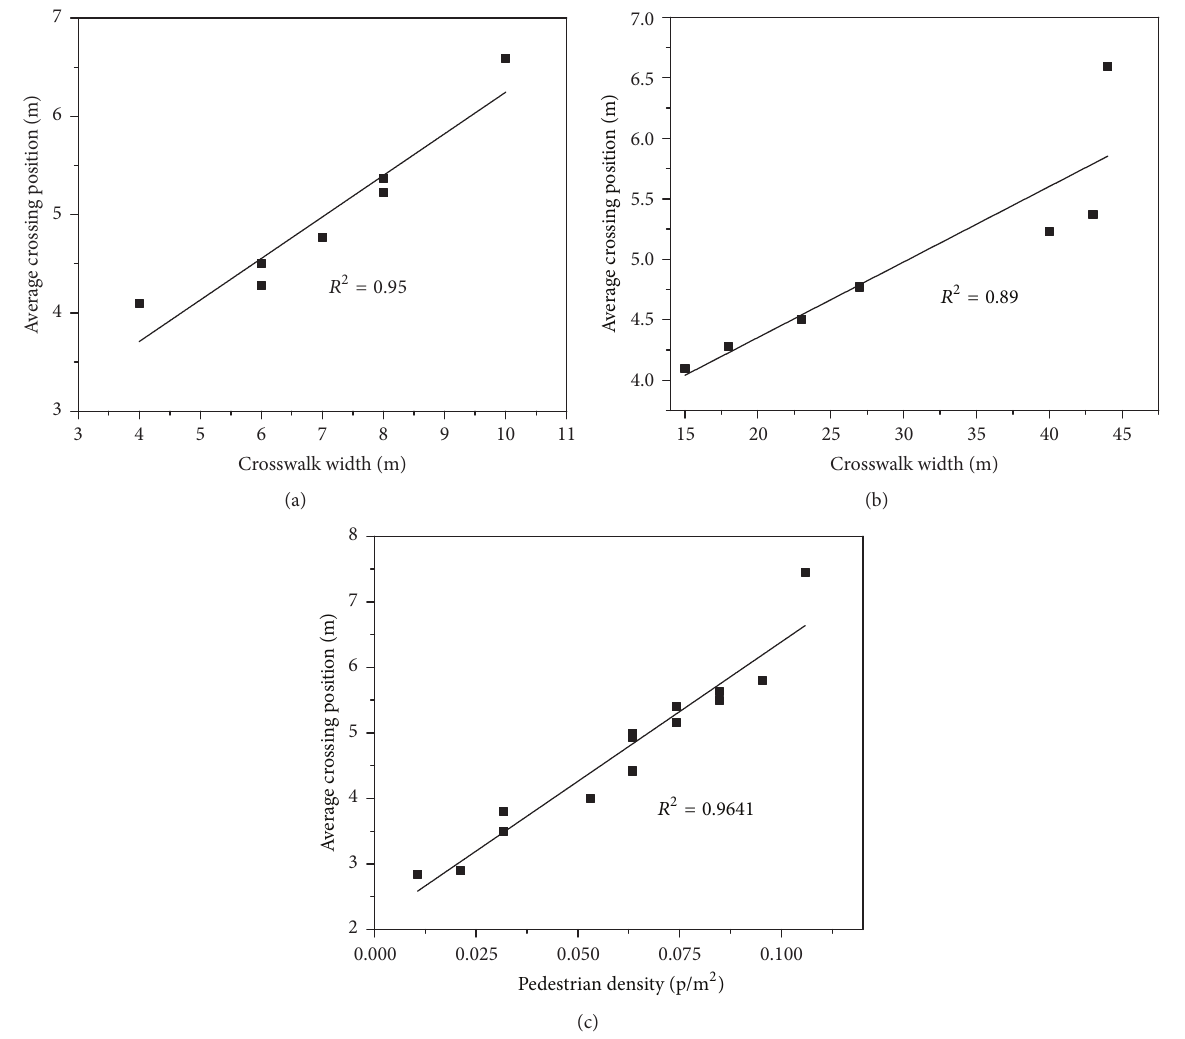
Figure 3: Relationship between factors and average waiting